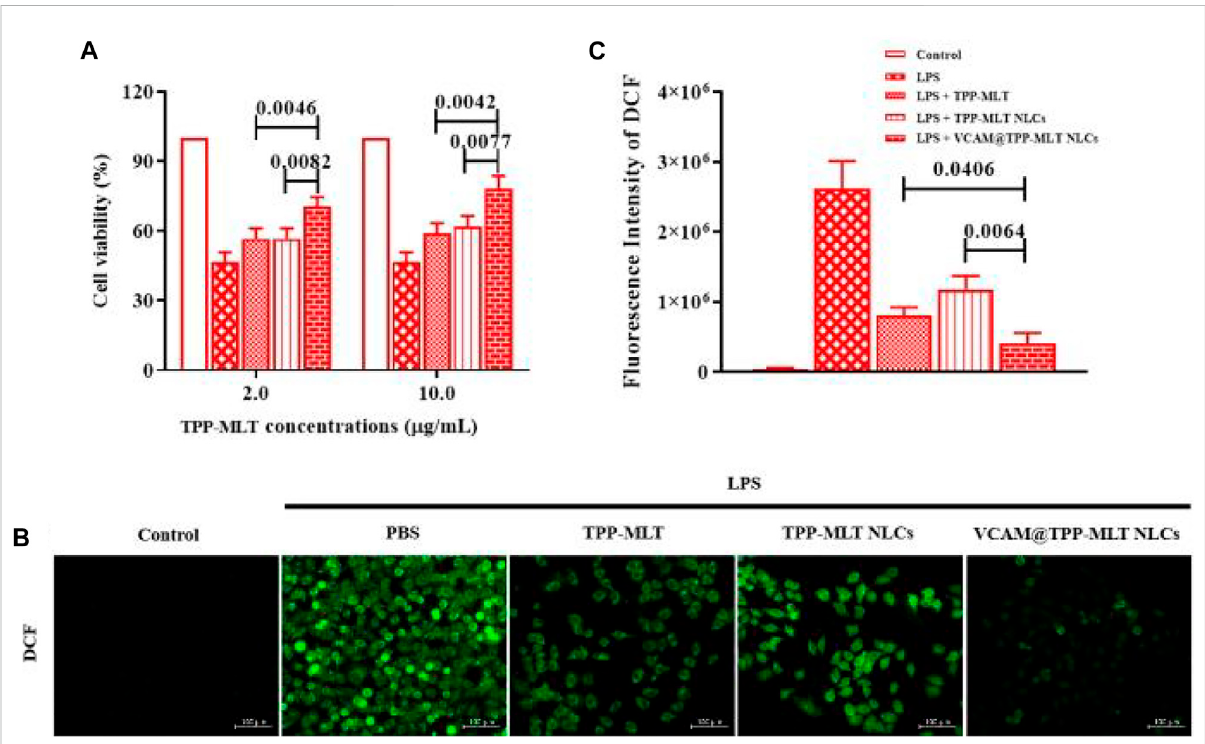
FIGURE 7 In vitro antioxidant activity of VCAM@TPP-MLT NLCs. (A) Cell viability of LPS-induced HUVECs after treated with VCAM@TPP-MLT NLCs, free TPP-MLT and TPP-MLT NLCs as control ( n = 3). (B) Representative fl uorescence images of intracellular ROS analysis with DCFH-DA in LPS-induced HUVECs (Scale bar, 100 μ m). (C) Semiquantitative analysis of DCF fl uorescence intensity in LPS-induced